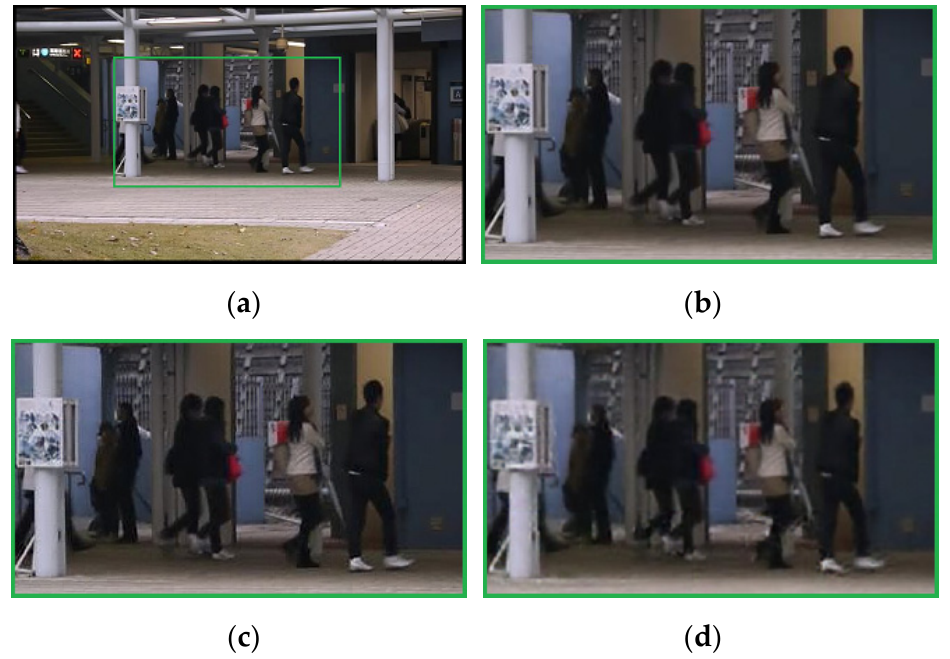
Figure 5. Experimental results on the CUHK dataset . The ground truth is shown in the first row and the generated outputs are shown in the second row: ( a ) The full ground truth, ( b ) the ground truth, ( c ) the output of the proposed method without refinement (PSNR = 32.87, SSIM = 0.935), ( d ) the output of the proposed method with refinement (PSNR = 31.39, SSIM = 0.914).